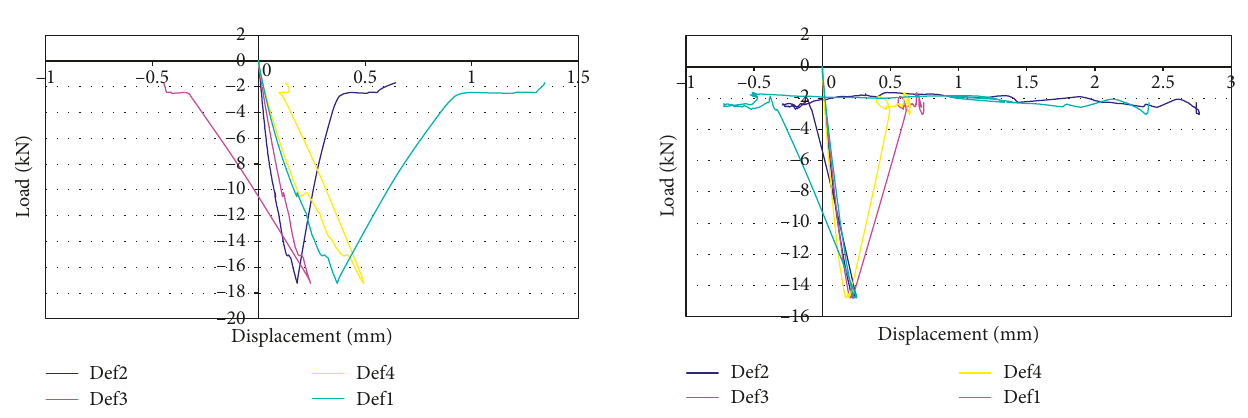
Figure 11: Load-displacement plot of the first triplet test.